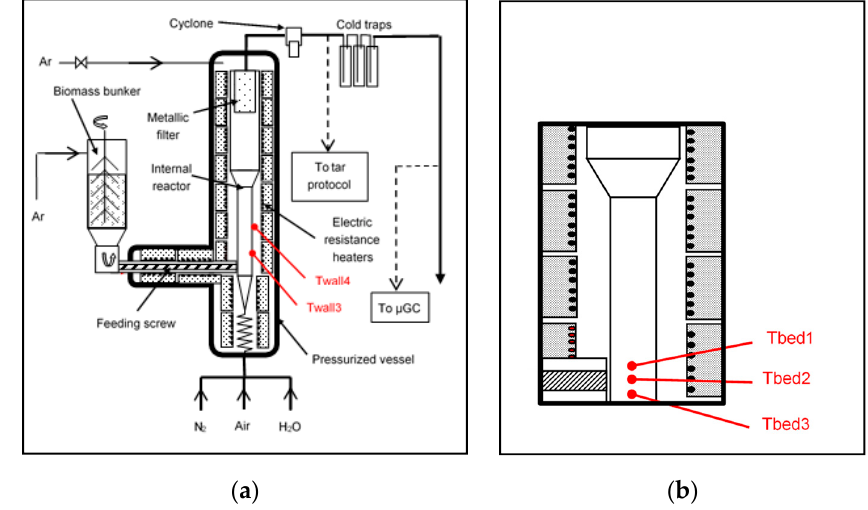
Figure 1. ( a ) Schematic diagram of the fluidised bed facility and ( b ) focus on the fluidised bed